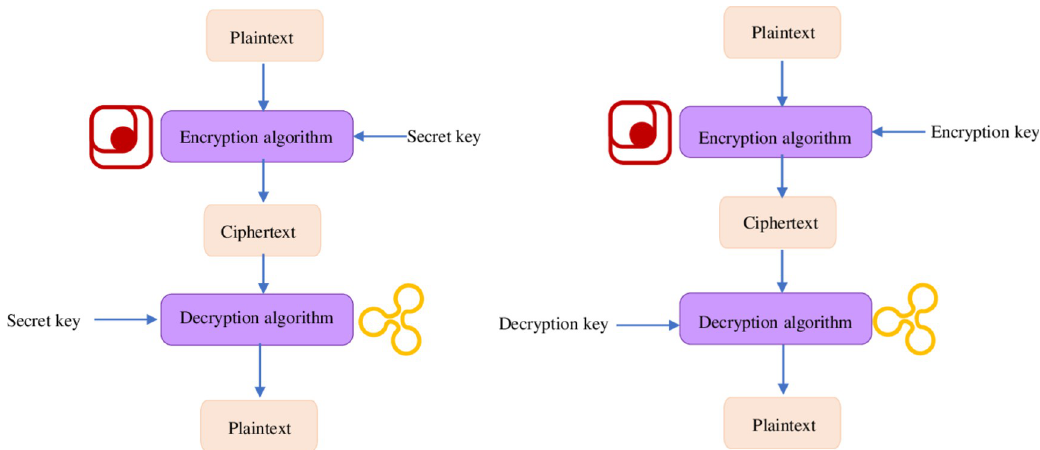
Fig 6. Data encryption technology (a. symmetric encryption; b. asymmetric encryption).